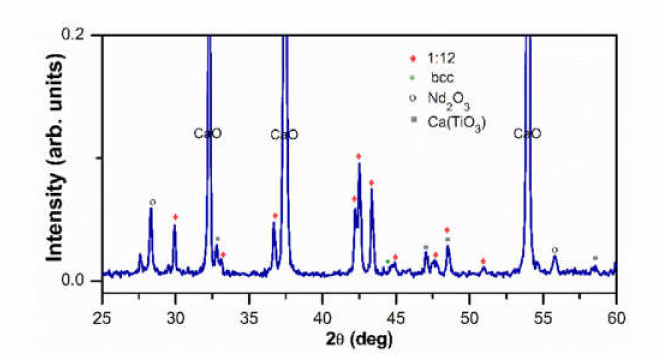
Figure 1. X-ray diffraction pattern of the Nd 1.1 Fe 10 CoTi powder annealed at 1000 ◦ C for 10 min.